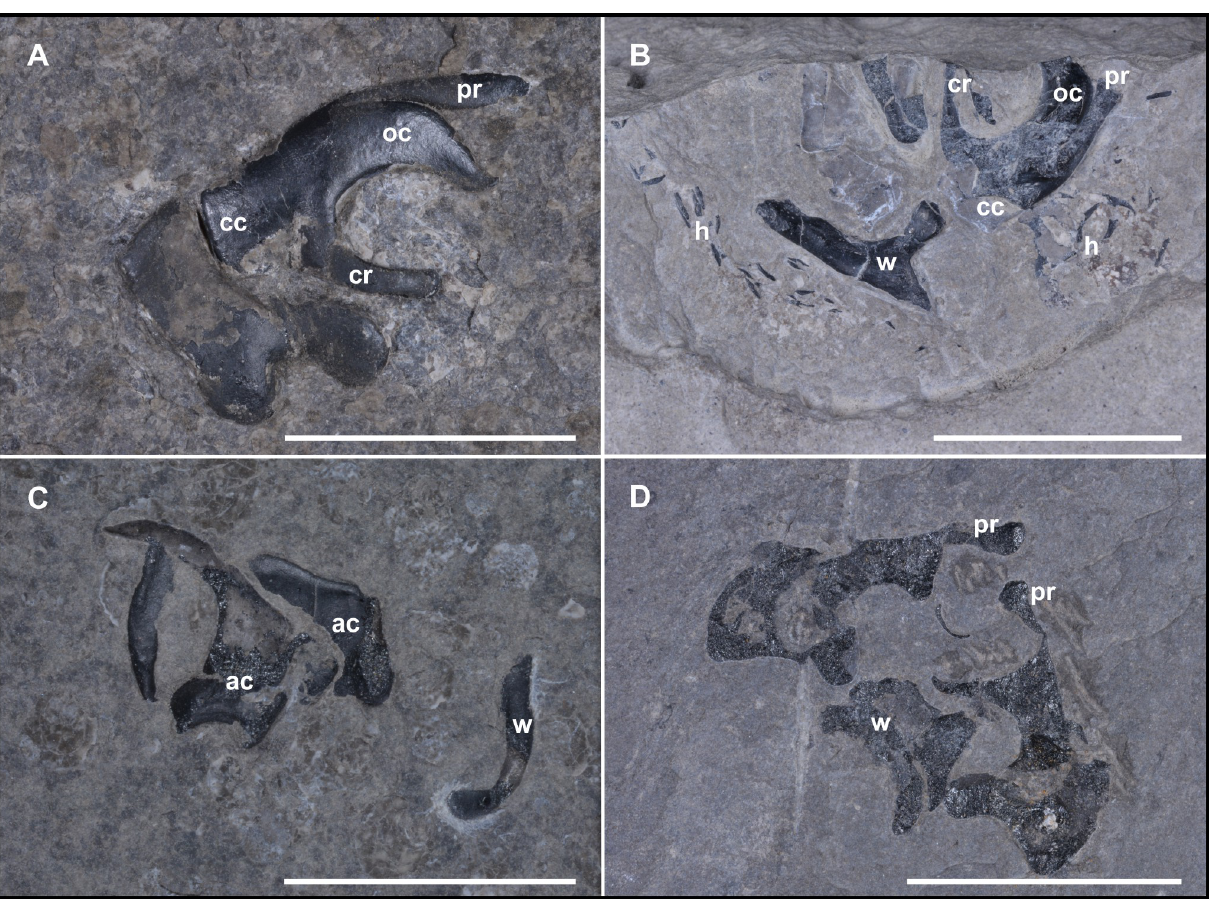
Fig 4. Different views of Type A (possible cephalic cartilage) and B specimens. (A) Standard "lateral" view of Type A fossils (NHMW 2012/0117/0001) with groove, characteristic processus on prominent C structure. (B) Supposed »cranial« view of Type A specimen (NHMW 2012/0117/0025) with associated wing-elements and in situ preserved hooks. (C) Two Type B fossils with a triangular base and two additional elongated elements (NHMW 2021/0124/0002). (D) Historical specimen from the Geological Survey Austria (GBA 2006/011/0041) from the Rinngraben ravine near Cave del Predil (Raibl, Italy). These specimens show a thicker and more prominent upper part of the C structure. cc cephalic cartilage, cr carrier, h belemnoid hooks, ac arm-cartilage, oc ocular cartilage, pr processus. All scale bars 1